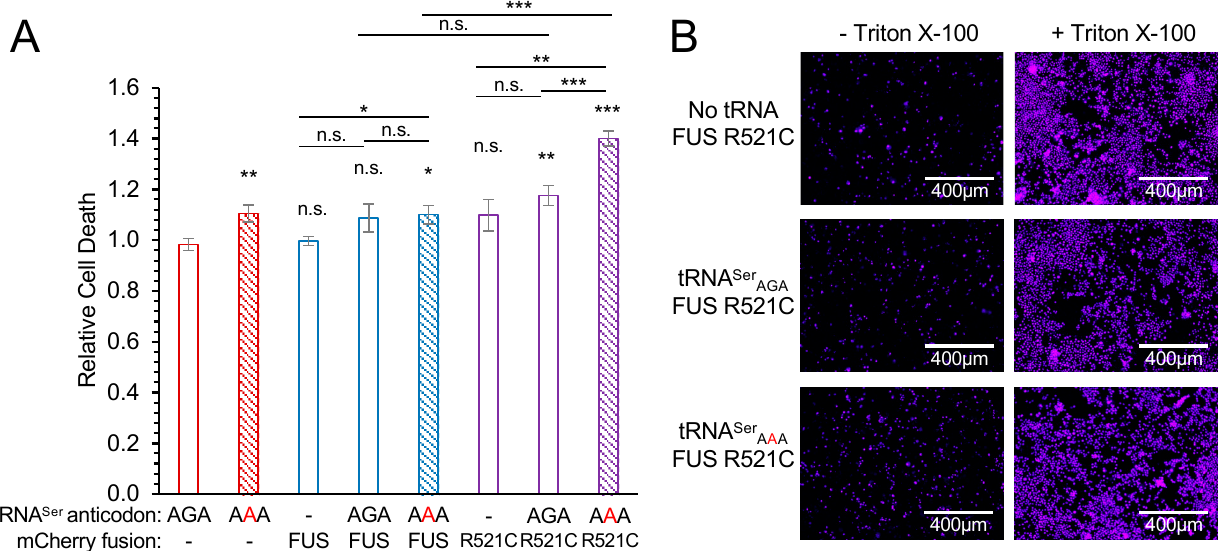
Figure 4. Synthetic toxicity of mistranslation and FUS R521C aggregation in N2a cells. N2a cells were transfected with a plasmid encoding no additional tRNA, human tRNA SerAGA , or G35A variant (tRNA SerAAA ) and mCherry, FUS-mCherry, or FUS R521C-mCherry. At 72 h post-transfection, cytotoxicity was assayed by determining relative levels of dead cells using Sytox blue dye and the ratio of fluorescence before (dead cells) and after (total cells) treatment with a cell membrane detergent (Triton X-100). ( A ) Biological means were normalized to the mean of the wild-type tRNA and mCherry control. Error bars represent the mean ± 1 standard deviation of five biological replicates. Significant differences from pairwise independent sample t-tests are indicated (n.s.—not significant, * p < 0.05, ** p < 0.01, *** p < 0.001). Annotations above each bar represent pairwise t-tests with AGA/mCherry; other pairwise t-test are indicated. ( B ) Representative images (see also Figure S3) were captured by fluorescence microscopy (CFP; ex. 445 nm, em. 510 nm).